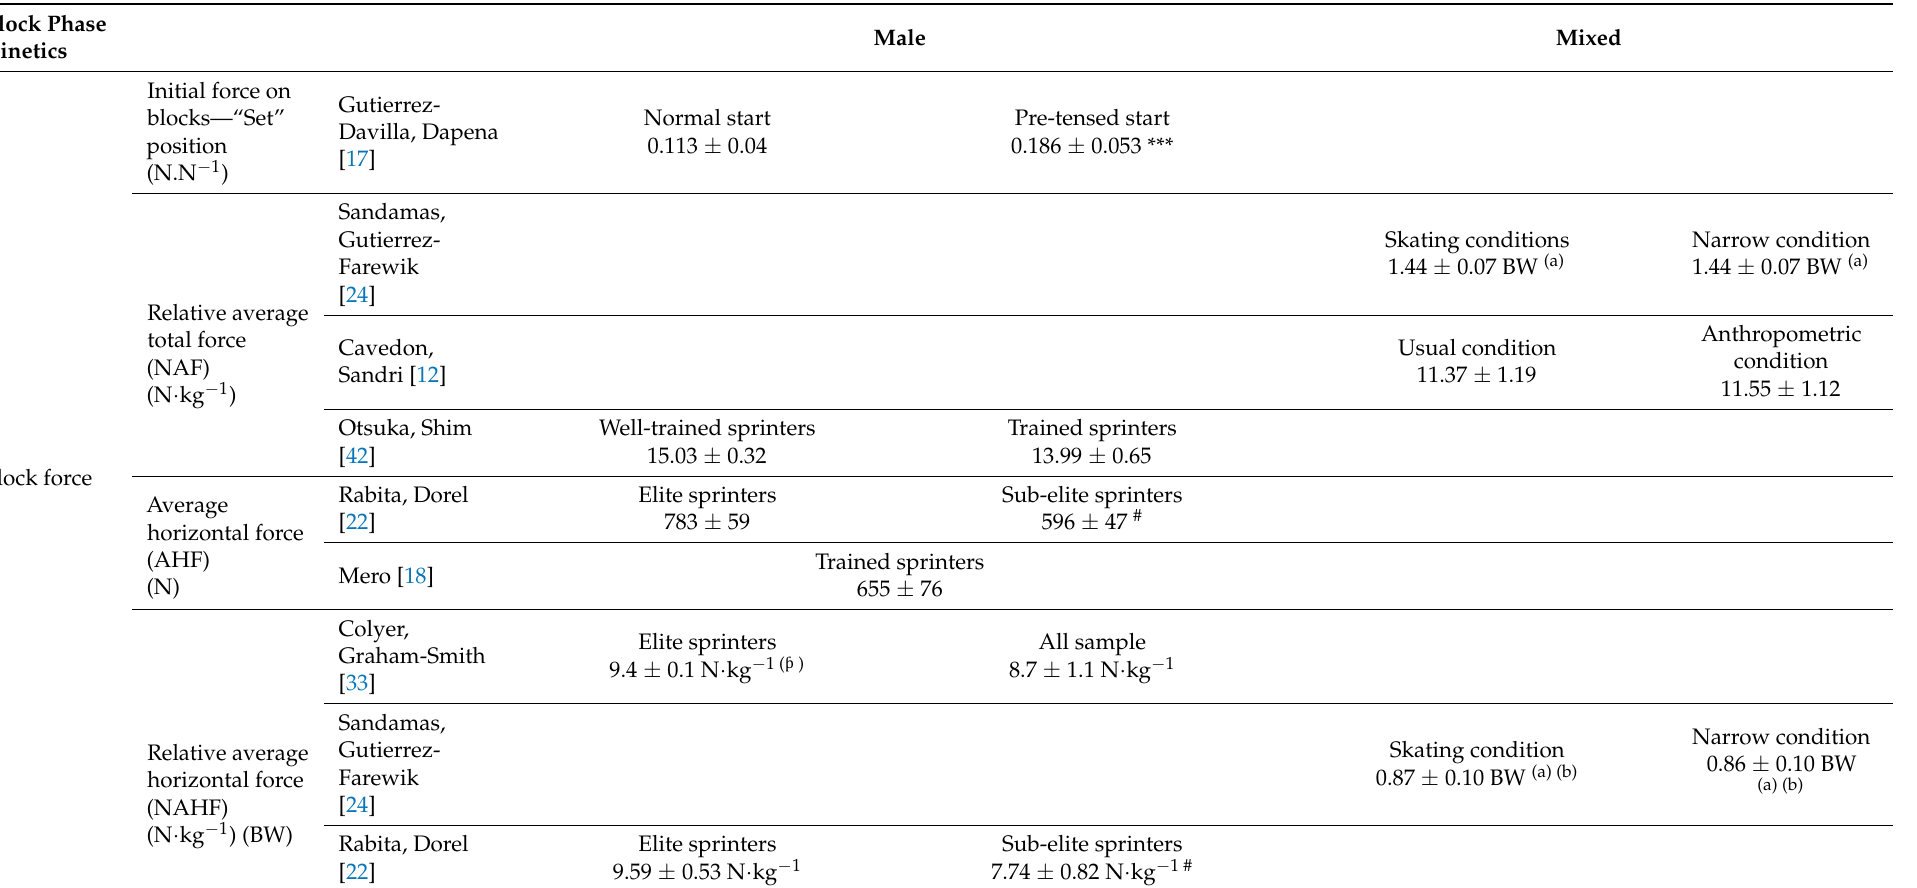
Table A3. Summary of the kinetic variables in the “Block Phase”. Data are the magnitude of the mean ± SD presented in the reviewed studies. Groups are male and mixed (when authors joined data without discriminating by sex) sprinters. Studies are listed, in each variable, in reverse-chronological order, followed by alphabetically for studies published in the same year. Data, terms, conditions, and sprinters’ performance levels are presented according to the original authors. Statistical differences between groups are marked with asterisks (* p < 0.05; ** p < 0.01; *** p < 0.001; # Cohen’s d—large effect size (>0.8); §§§ large effect size [1.2–1.6] of 90% confidence intervals; size: >0.3) with average horizontal power produced across the block